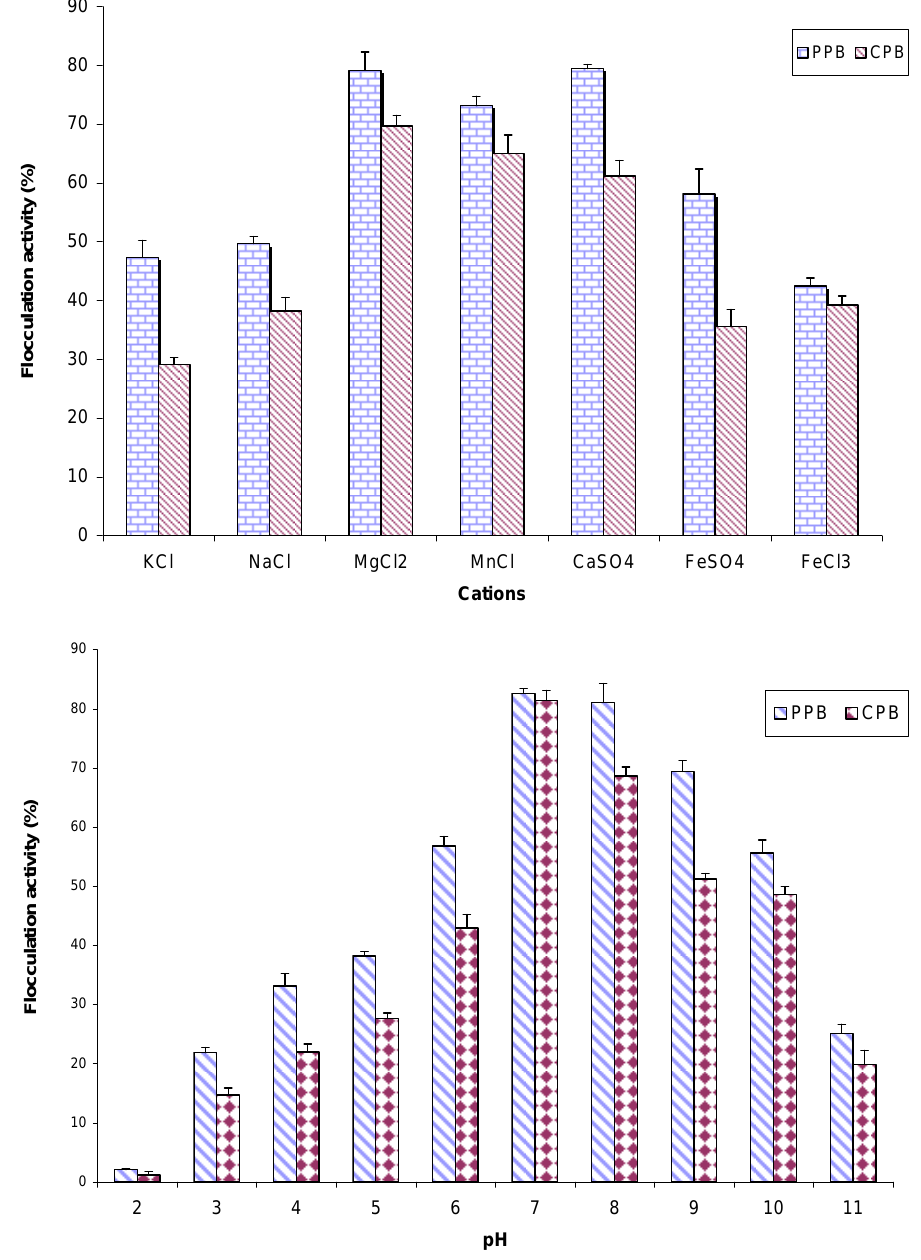
Figure 4. The effects of cations and medium pH on the flocculating activity of purified bioflocculant produced by Brachybacterium sp.